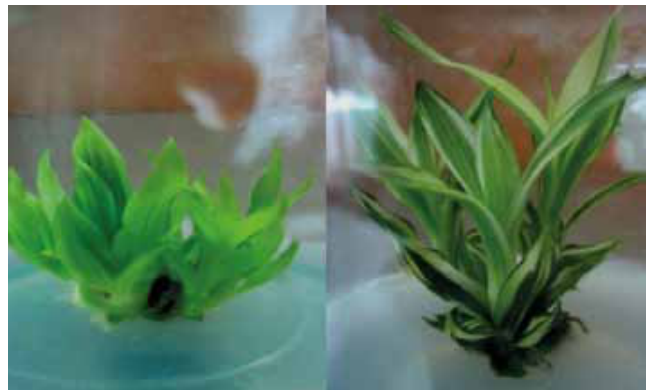
2 - Rate of shoot proliferation in Dracaena ‘Variegated’ cultured horizontally on 1/2 MS medium with 2 mg l -1 BA and 0.25 mg l -1 NAA- 55 days after culture (left) and on 1/2 MS medium with